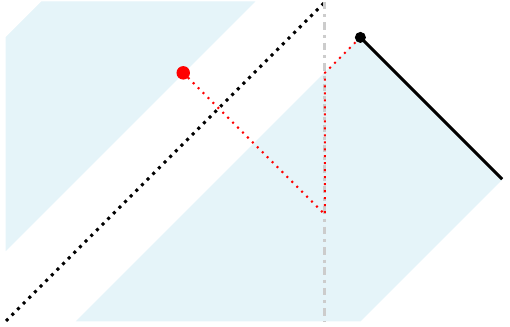
Figure 4 . The relationship between a point in ∂R in black and a QES ∂I in red. At leading order in the adiabatic limit, the U coordinate of the QES is determined by reflection U → − U . The v coordinate of the QES is equal to the u coordinate of the point in ∂R minus the scrambling time. This is subleading in the adiabatic limit but is nevertheless significant because it means that the QES lies close to the